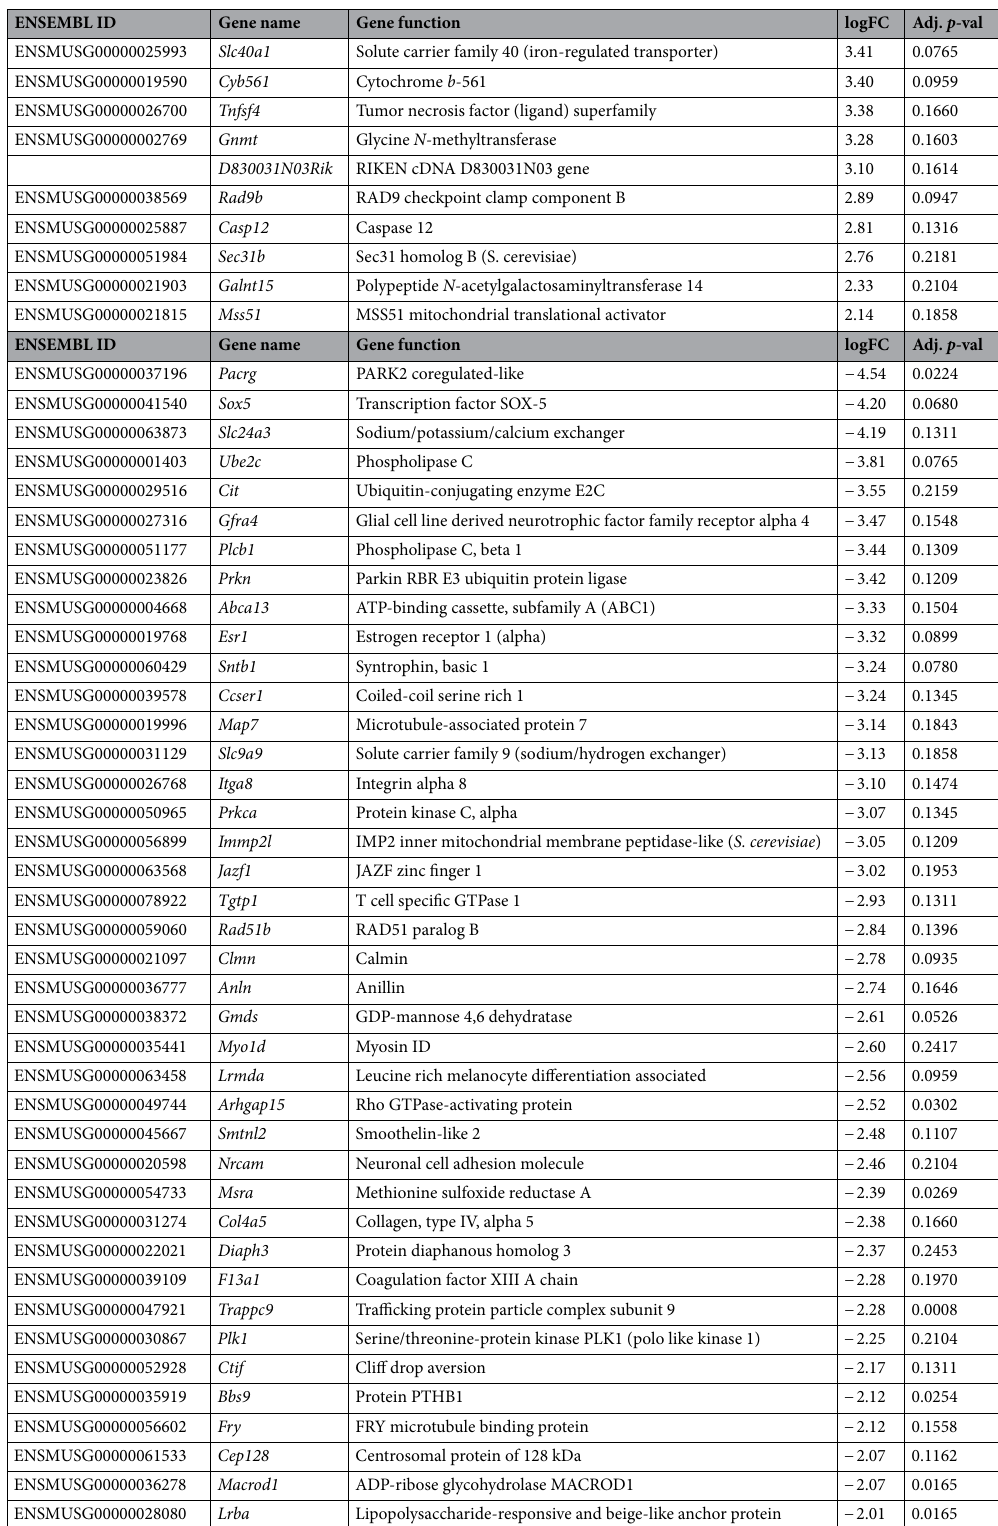
Table 2. Lists of DEGs in LPS-tolerant macrophages in the presence of carboplatin, |log2FC| > 2, p <